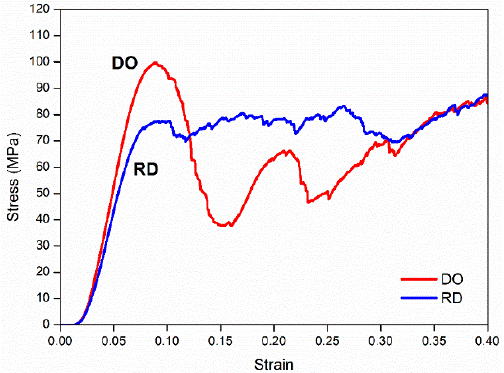
Figure 7. Mechanical behavior of scaffolds under compression for DO and RD geometries.